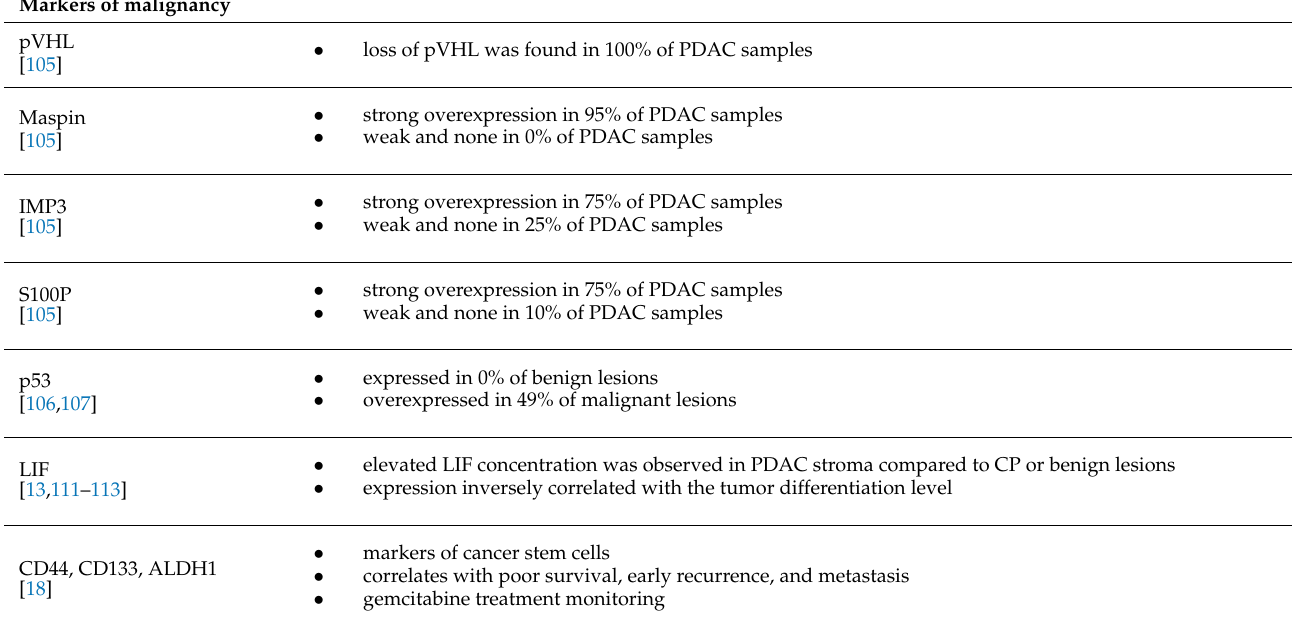
Table 2. Summary of immunohistochemical staining features of PDAC. pVHL, von-Hippel-Lindau gene protein; IMP3, insulin-like growth factor-II mRNA-binding protein 3; S100P, S100 calcium- binding protein P; LIF, leukemia inhibitory factor; ALDH1, aldehyde dehydrogenase 1; CP,